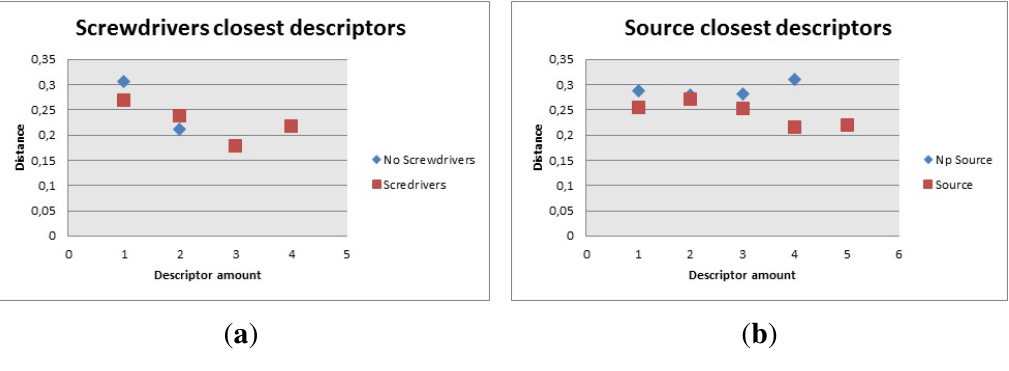
Figure 24. Closest descriptors with and without object (screwdrivers and power source). ( a ) Closest descriptors with and without screwdrivers; and ( b ) Closest descriptors with and without power